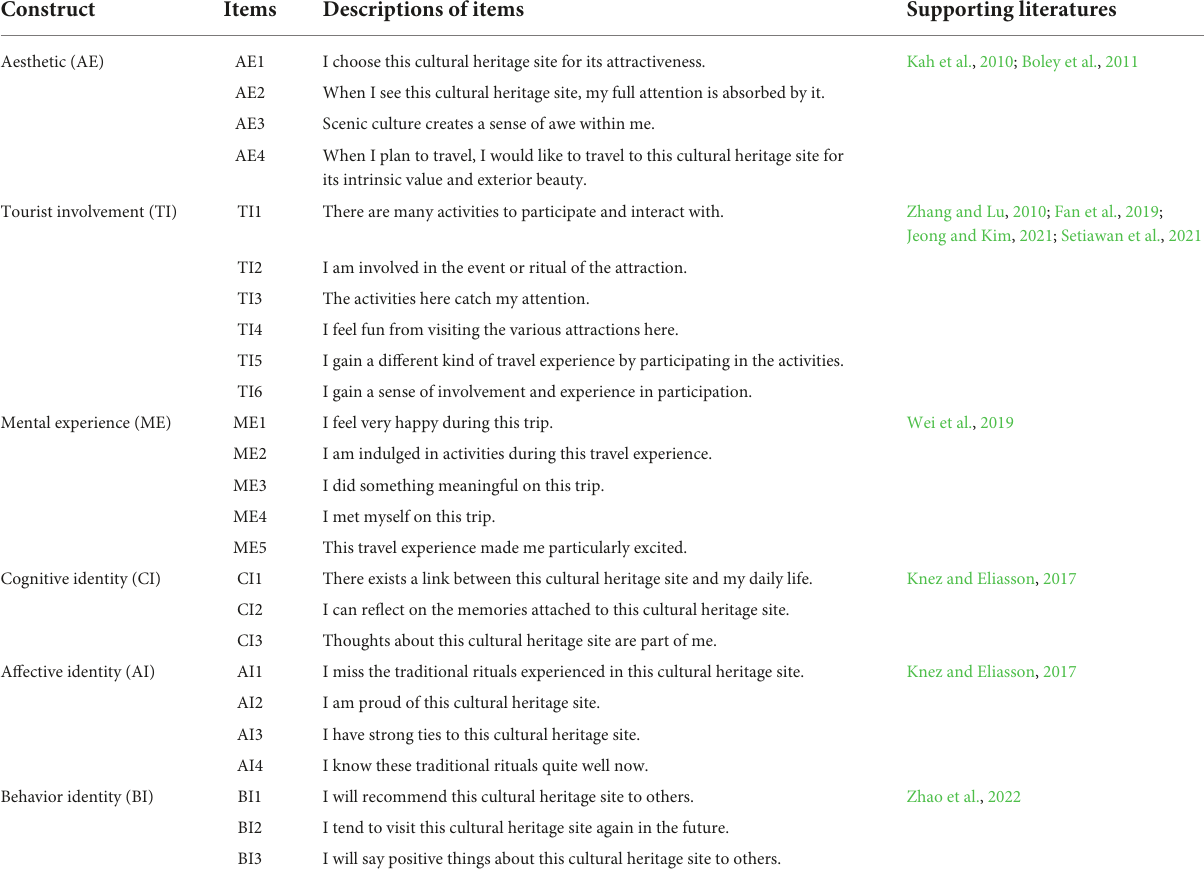
TABLE 1 Measurement items.